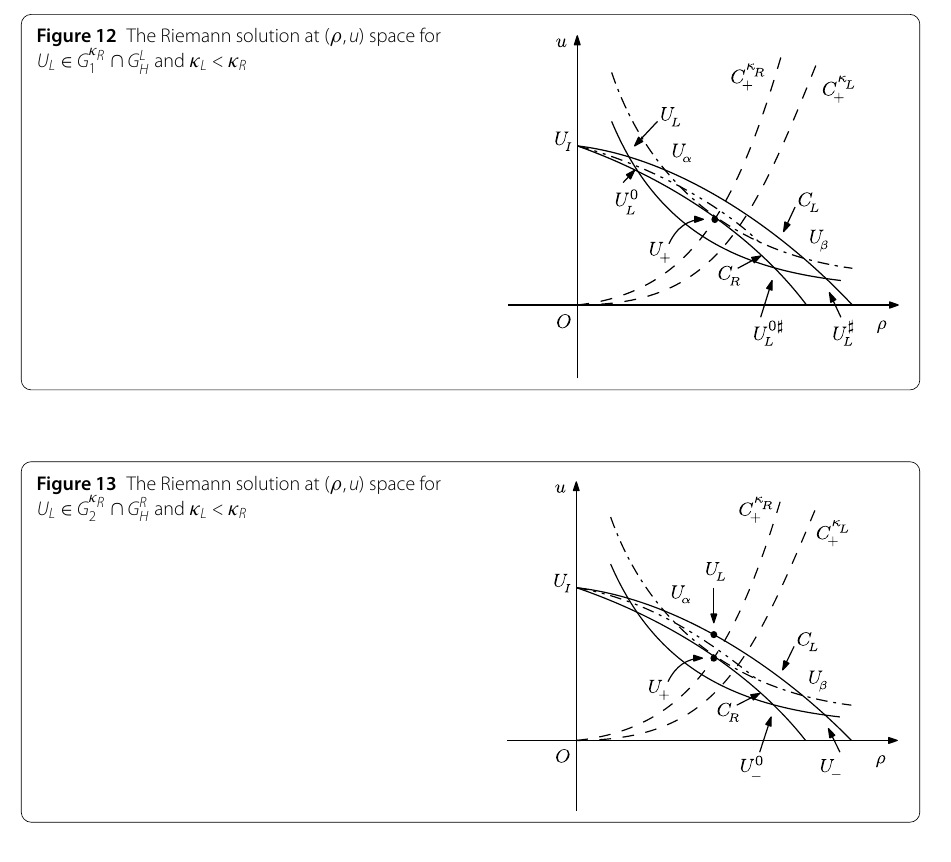
Figure 12 The Riemann solution at ( ρ , u ) space for U